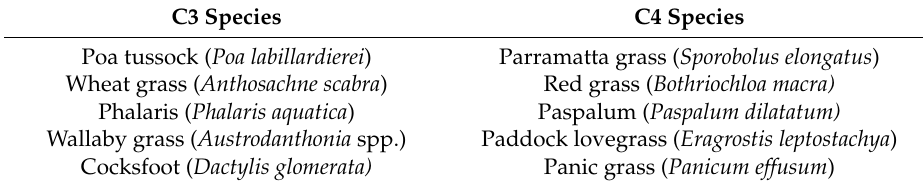
Table 2. Common native and introduced pasture species observed in the study sites that constituted the three classes of C3, C4, and mixed. A mixed class in a given site was ascribed when neither C3 nor C4 constituted at least 70% of the species